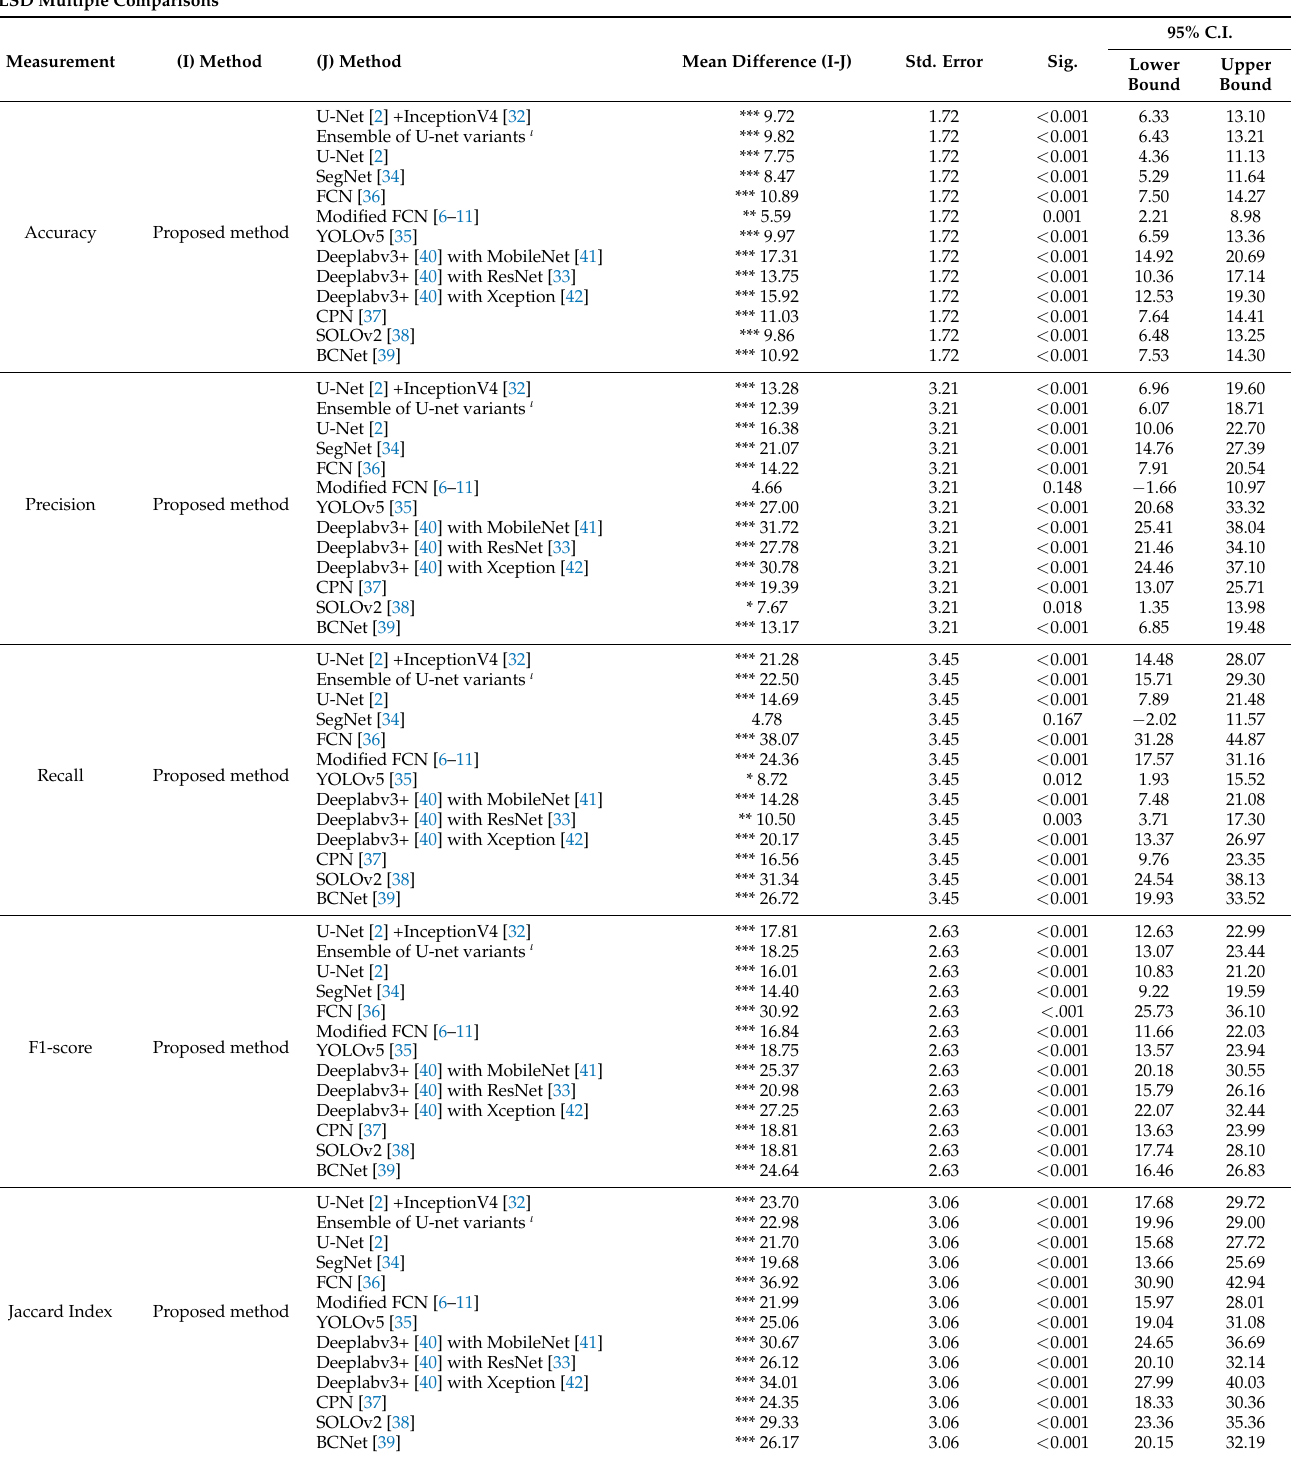
Table 5. Statistical analysis to compare the proposed method with benchmark approaches using the LSD test on DISH dataset